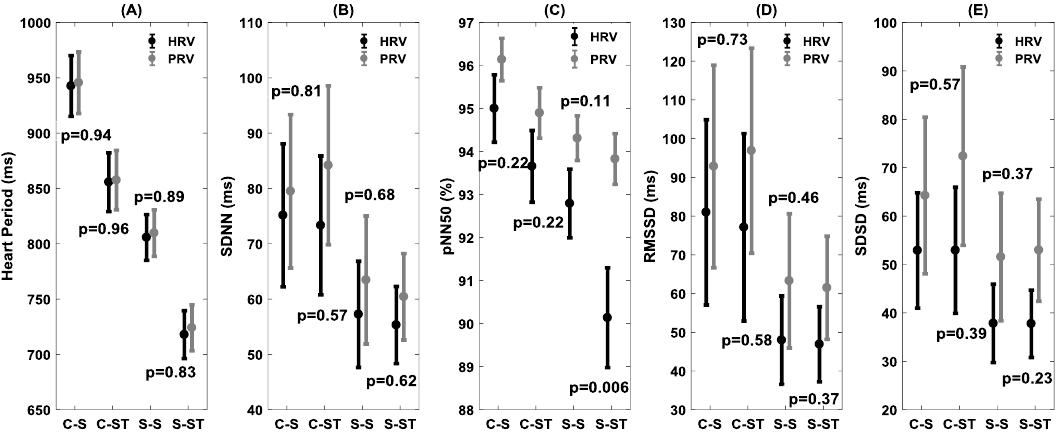
Figure 5. Statistical comparison of HRV and PRV for two groups (control / stroke) and two conditions (sit / stand) for di ff erent time domain measures i.e., heart period ( A ), SDNN ( B ), pNN50 ( C ), RMSSD ( D ), and SDSD ( E ). The figure represents the distribution (mean ± SE) in control–sit (C–S), control–stand (C–ST), stroke–sit (S–S), and stroke–stand (S–ST). The figure also lists the statistical p-value of the